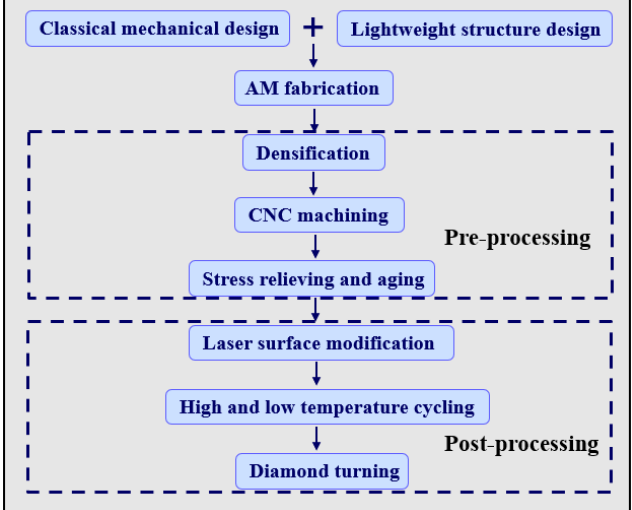
Figure 10. Processing chain to generate the truss-structured mirrors.